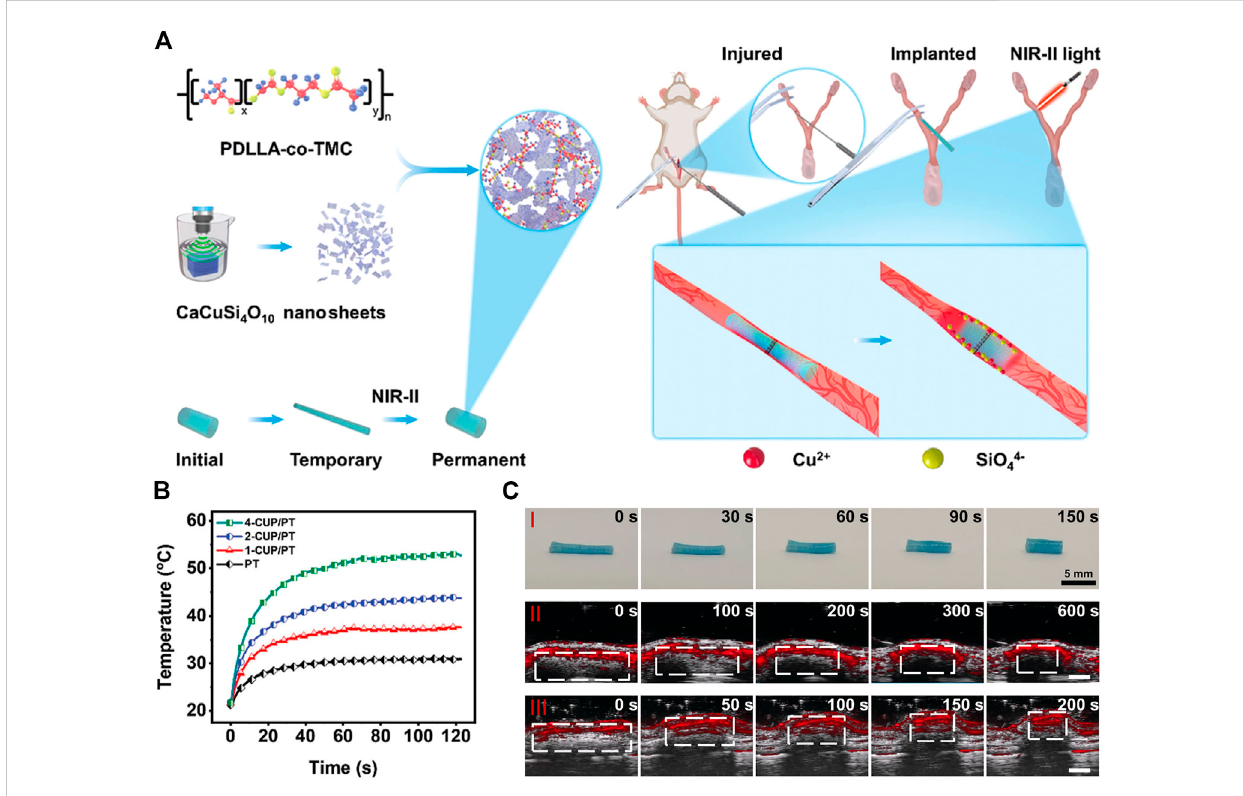
FIGURE 6 (A) SchematicillustrationofthetherapeuticstrategyforIUApreventionbasedonCUP/PT. (B) PhotothermalpropertyofPTandCUP/PTunder1064- nm laser irradiation. (C) Shape recovery of CUP/PT at different time after irradiation on a desk (I), underneath the skin (II), and inside the isolated uterine lumen of rat (III), respectively. (Adapted with permission from Dong et al., 2022. Copyright 2022